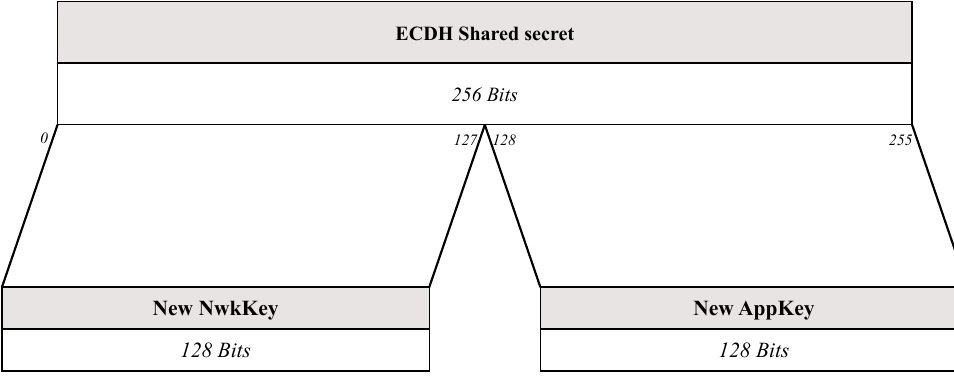
Figure 2. New Root Keys